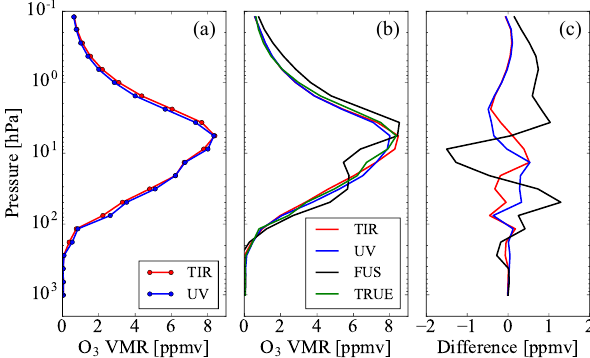
Figure 1. (a) True ozone profiles related to TIR (red line) and UV (blue line) measurements. (b) Ozone profiles obtained from TIR measurement (red line), from UV measurement (blue line), from the data fusion (black line) compared with the mean value of the true profiles (green line). (c) Residual errors obtained as differences of the ozone profiles obtained from TIR measurement (red line), from UV measurement (blue line) and from data fusion (black line) from the mean value of true profiles. All the reported quantities are related to case 1.